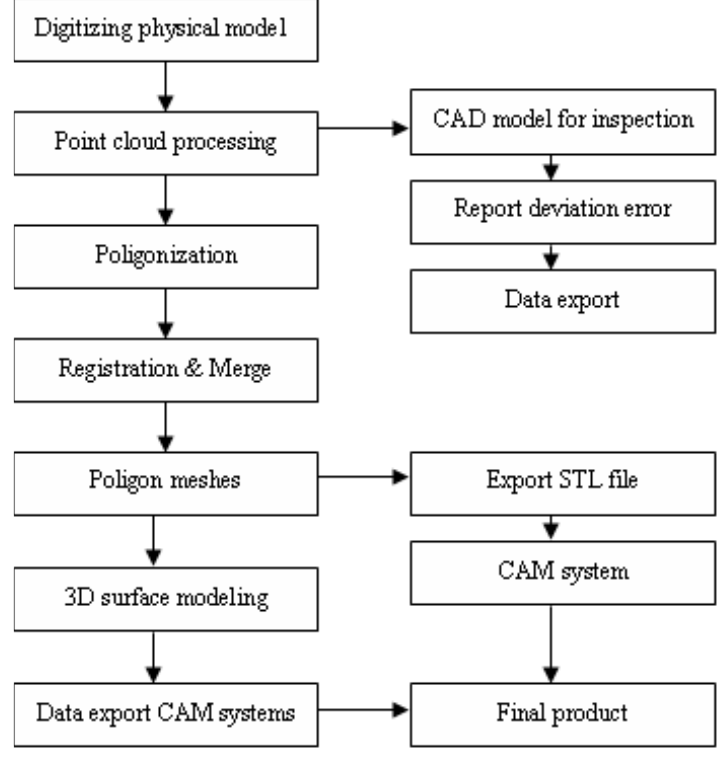
Figure 1. 3D Digitizing process and it’s applications in the automotive